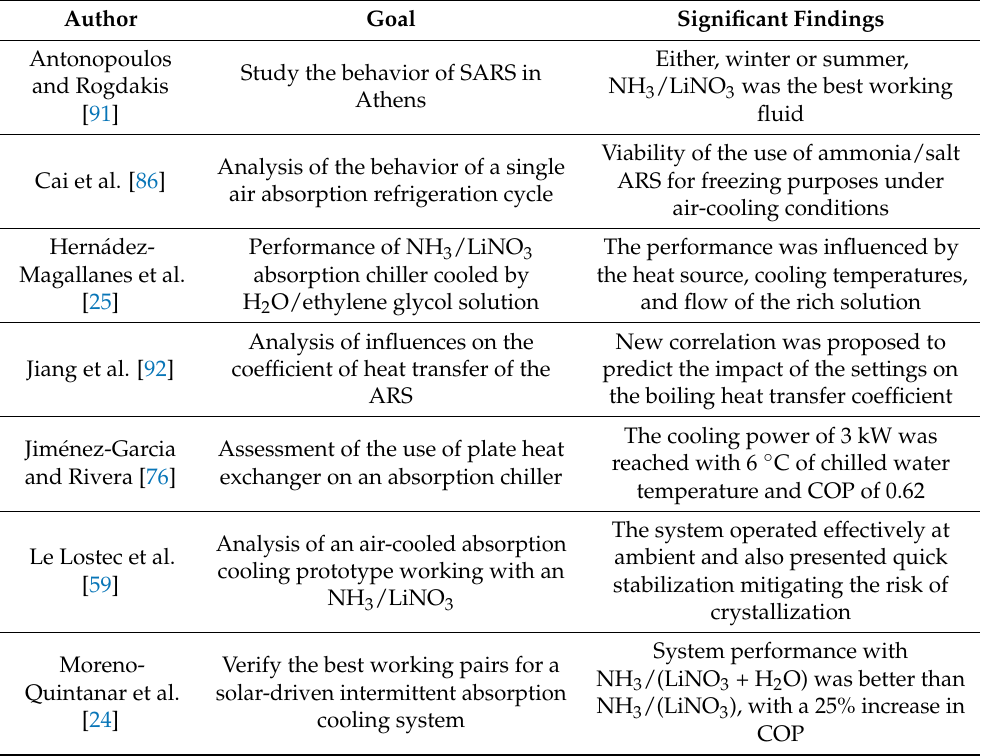
Table 7. Assessment of absorption refrigeration systems using the experimental